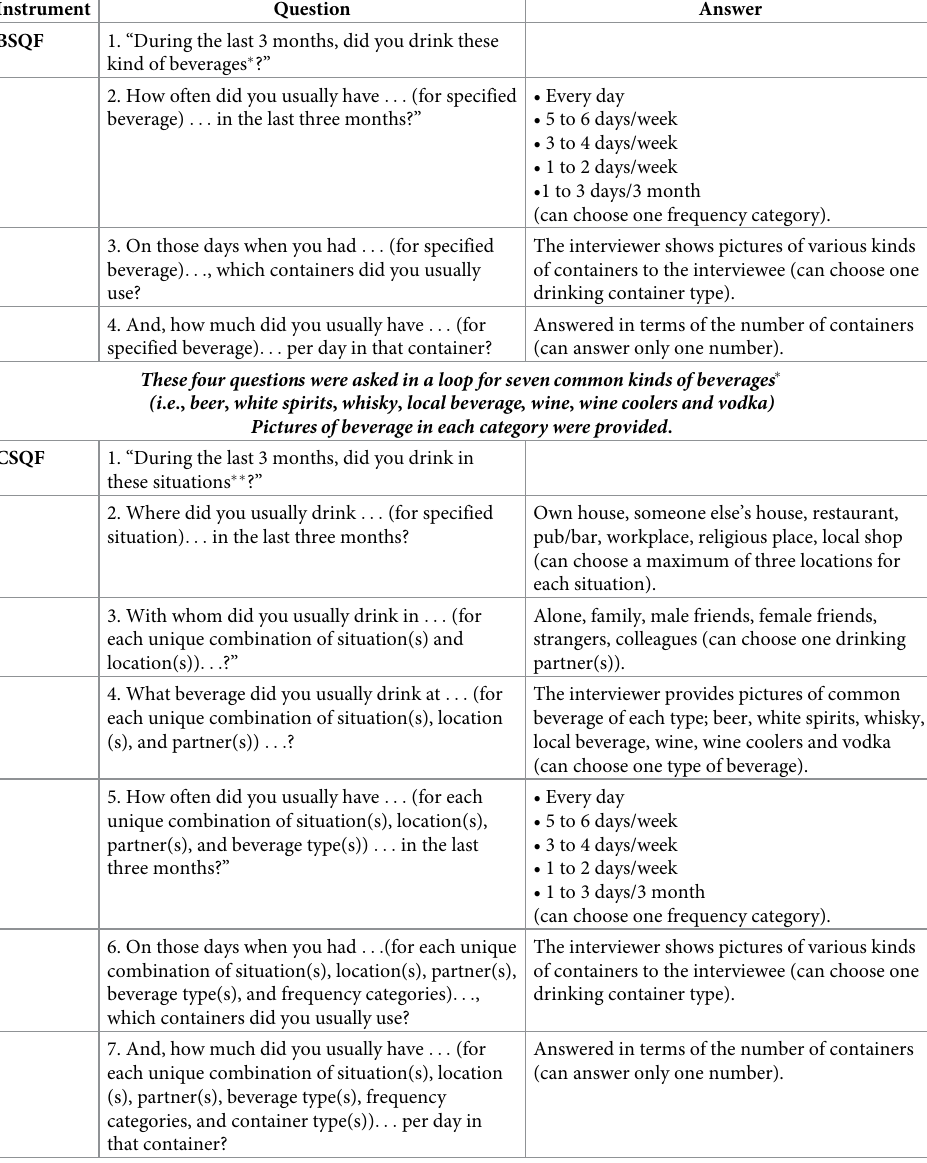
Table 1. Questions used for the BSQF and CSQF